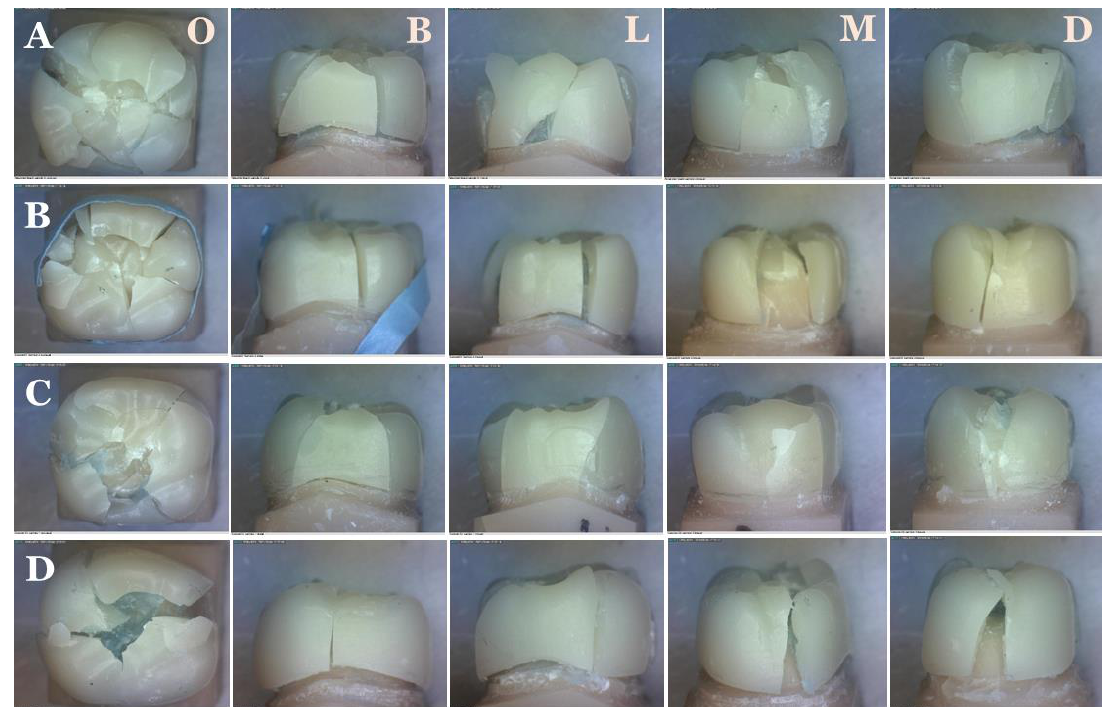
Figure 3. Crown fracture under load. AmannGirrbach (Amann Girrbach GmbH, Pforzheim, Germany) ( A ), Cercon HT (Dentsply Sirona, Bensheim, Germany), ( B ), Cercon XT (Dentsply Sirona, Bensheim, Germany) ( C ), and Vita YZ XT (Zahnfabrik, Bäd Sackingen, Germany) ( D ). O = Occlusal, B = Buccal, L = Lingial, M = Mesial, and D = Distal. Table 3. Multiple comparisons of the fracture load of zirconia crowns among various groups. AmannGirrbach Cercon HT Cercon XT Vita YZ XT AmannGirrbach